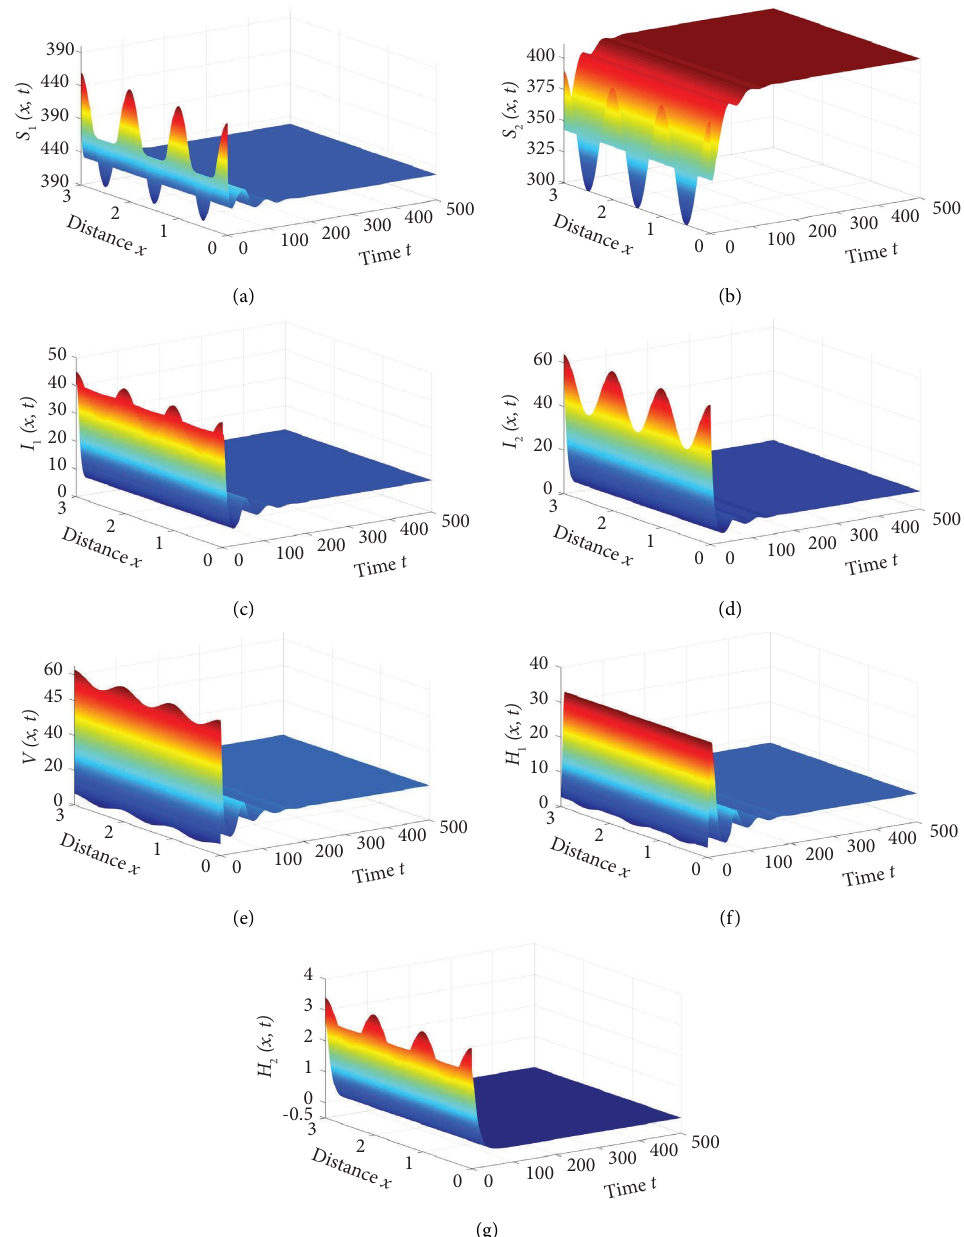
Figure 3: Solution of system (75) with the initial conditions (77), for Case III. R � ( 428 . 5714 , 411 . 7647 , 11 . 4286 , 8 . 2353 , 20 , 8 . 1513 , 0 ) is G.A.S. (a, b) Target cells. (c, d) DENV-infected cells. (e) DENV particles. (f) Π 2 Heterologous antibodies. (g) Homologous